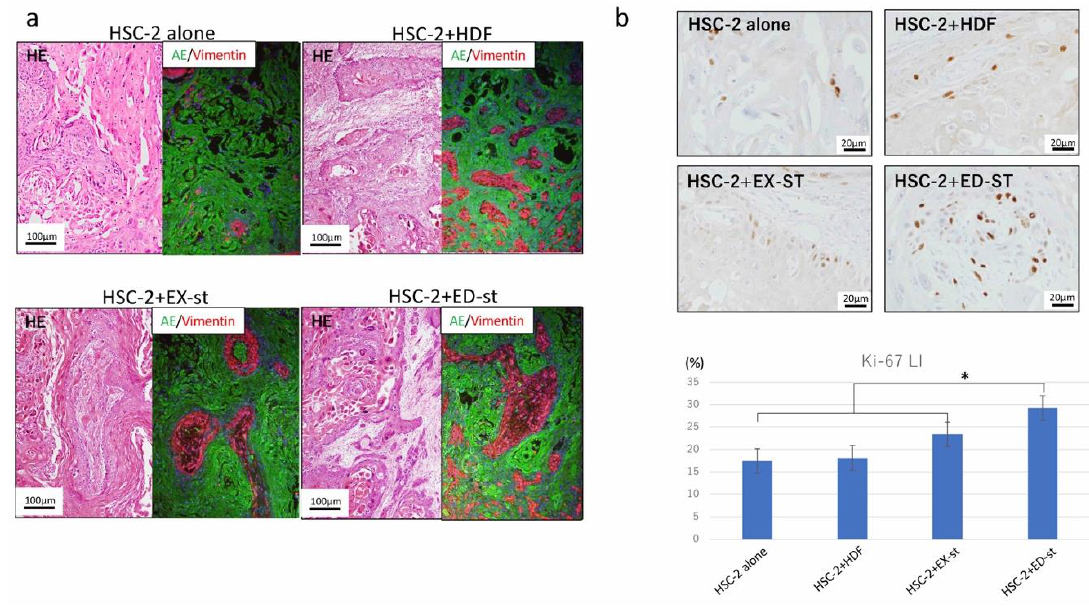
Figure 5. Histological images of the xenograft model and Ki-67 labeling index. ( a ) In the HSC-2 alone group, tumor tissue formation with marked keratinized tumor nests was observed. The histological findings of the HSC-2/HDF group showed islands of well-differentiated squamous cell carcinoma. In the HSC-2/EX-st group, the forming tumor tissue showed verrucous squamous cell carcinoma-like morphology with dendritic stroma. The tumor tissue showed marked surface keratinization, so-called church-spire keratosis. The HSC-2/ED-st group showed histological findings of well to moderately differentiated squamous cell carcinoma with islands and cords of tumor cells with evident squamous differentiation. ( b ) The Ki-67 labeling index in both the HSC-2/ED-st groups was significantly higher than that of the HSC-2 alone, the HSC-2/HDF and HSC-2/EX-st group. n = 4, * p < 0.05.